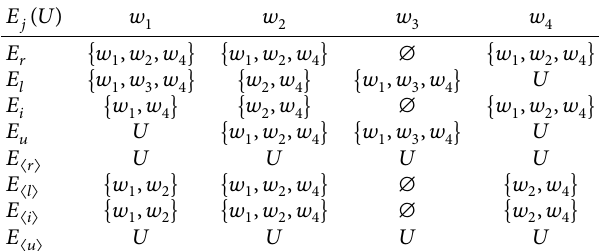
Table 2: E j -neighborhoods of each element in